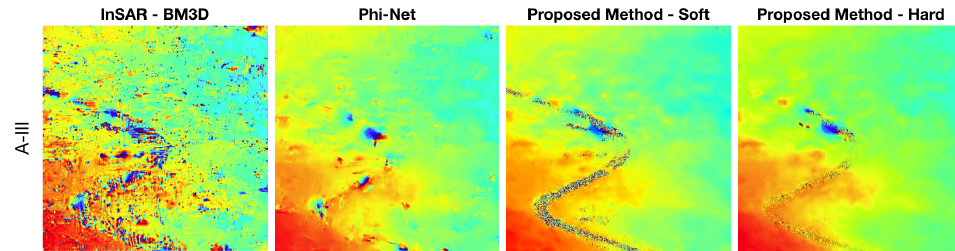
Figure 20. Filtered interferometric phase images of the considered site A-III estimated using all the compared methods.